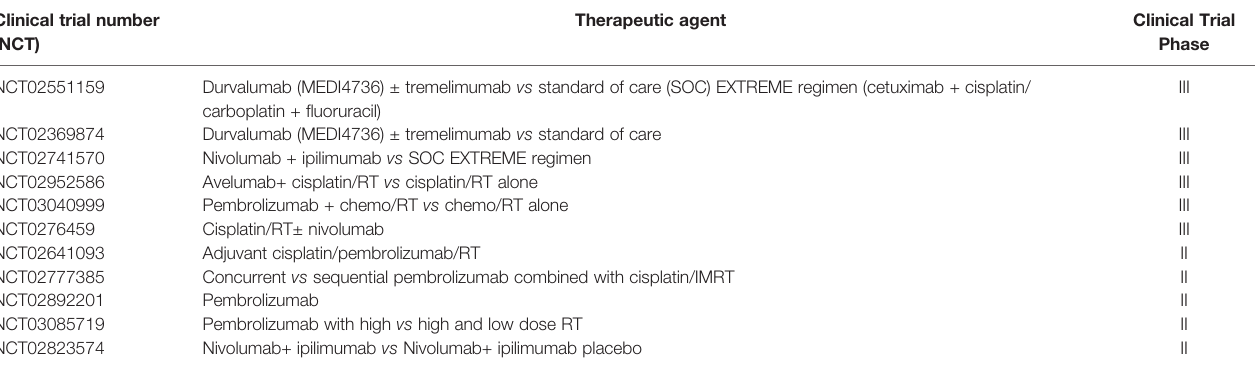
TABLE 7 | Clinical trials of the combination of small molecules with immunogens against HNC. Clinical trial number (NCT)